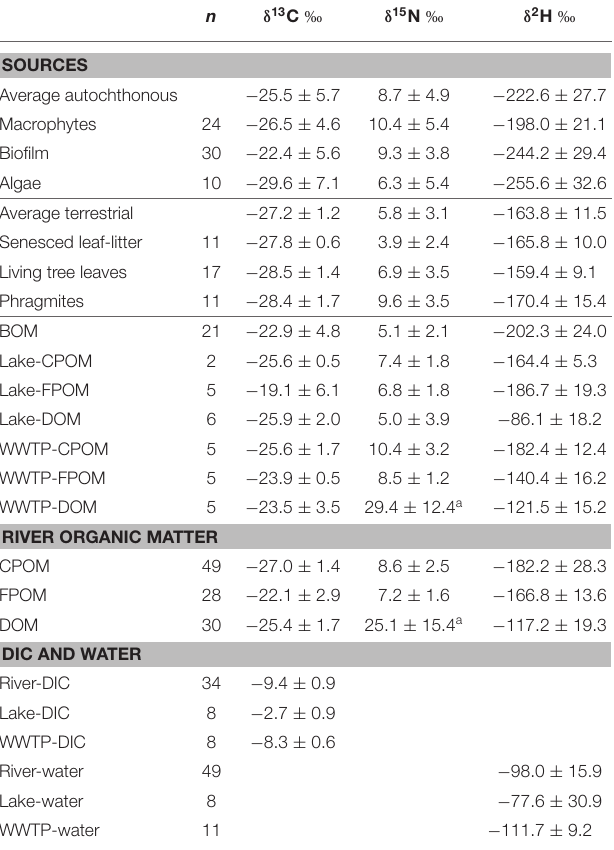
TABLE 1 | Carbon, nitrogen, and hydrogen isotope mean and standard deviation for potential sources of Jordan River organic matter (OM)